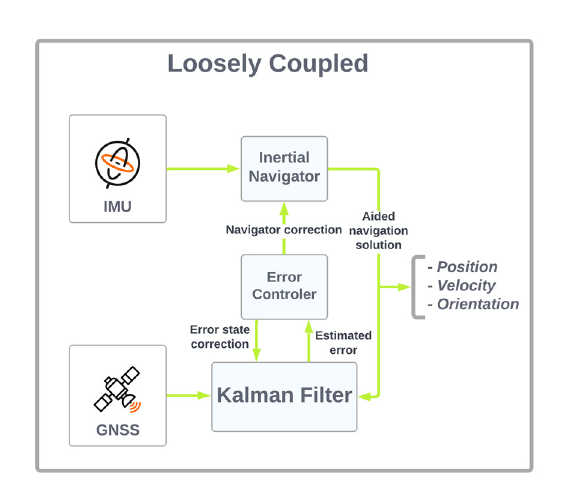
Figure 1. The loosely coupled scheme in GNSS/IMU